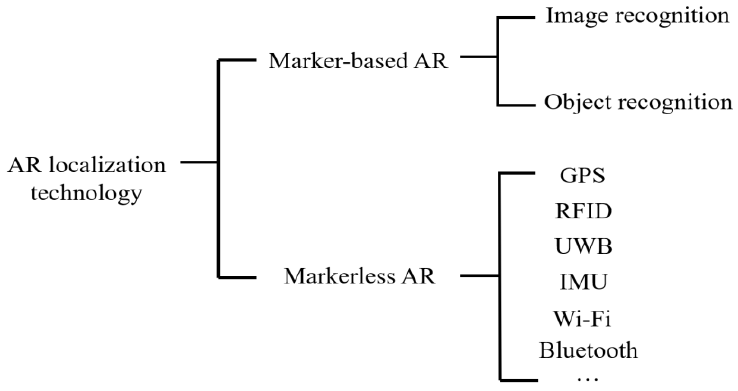
Figure 16. AR localization technology.